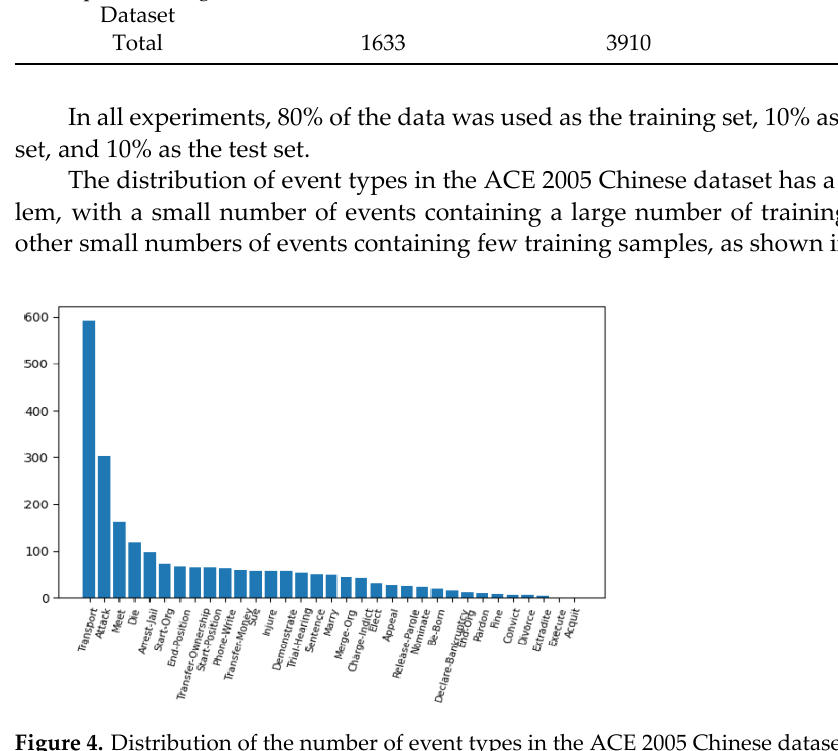
Figure 4. Distribution of the number of event types in the ACE 2005 Chinese